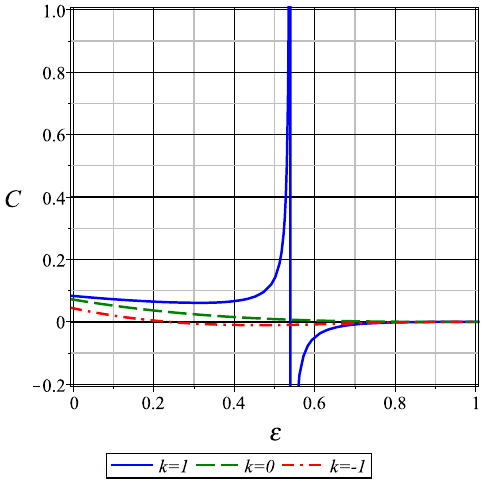
Fig. 11 P − r + (left) and G − T (right) diagrams for e = m = c 0 = c 1 = c 2 = c 3 = g (ε) = 1 and k ef f = 1 ( k = 1 with c 2 = 0 or k = 0 with c 2 = 1 or k = − 1 with c 2 = 2). The blue dashed line corresponds to the critical temperature (left) and the critical pressure